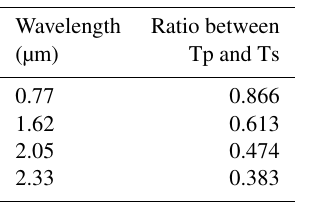
Table 3. Ratio between P-polarized and S-polarized transmittances predicted for GeoCarb ( w = 36µm, L = 1mm), using a SH diffrac- tion model and assuming a rectangular pupil ( F number =